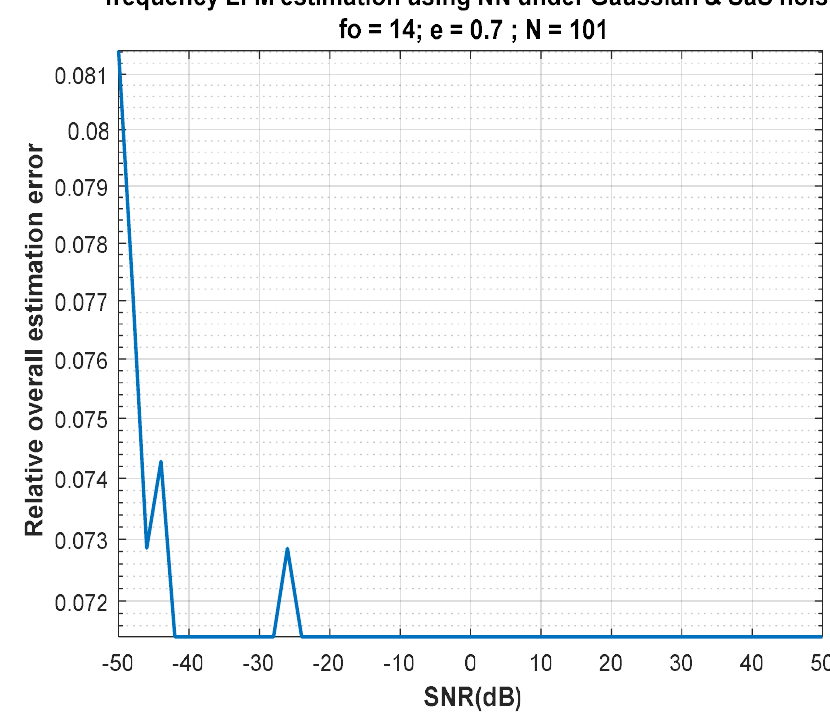
Figure 15. Error rate for FE of noisy LFM signals by DNN.